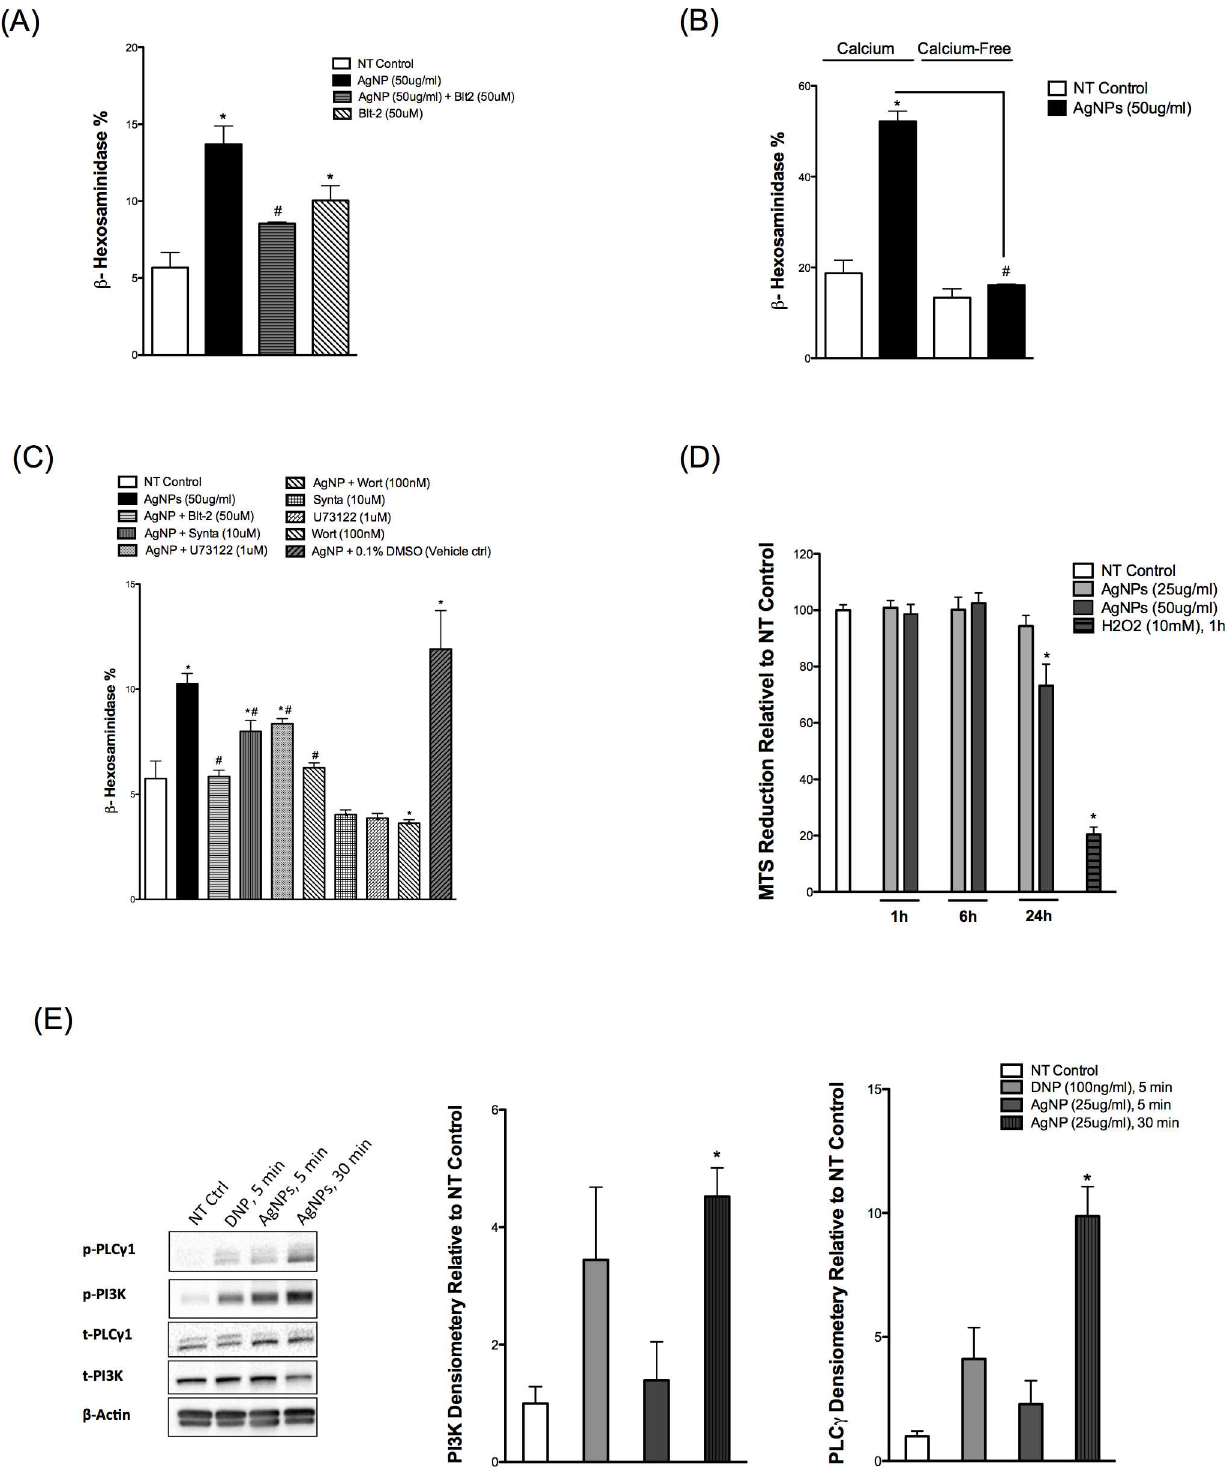
Fig 6. Confirmation of BMMCs results in RBL-2H3 (A) Cells were pre-treatedwith Blt-2 (50 μ M) 30 min prior to AgNP (50 μ g/ml) exposure for 1 h and release of β -hexosaminidasewas assessedinto supernatants. (B) Mast cells degranulation was measuredfollowingexposureto AgNPs (50 μ g/ml) in the presenceand absenceof calcium. (C) Cells were pre-treatedwith the indicatedinhibitors 30 min prior to AgNP (50 μ g/ ml) exposurefor 1 h and release of β -hexosaminidasewas assessedinto supernatants. (D) Cells were treated with AgNPs (25 or 50 μ g/ml)